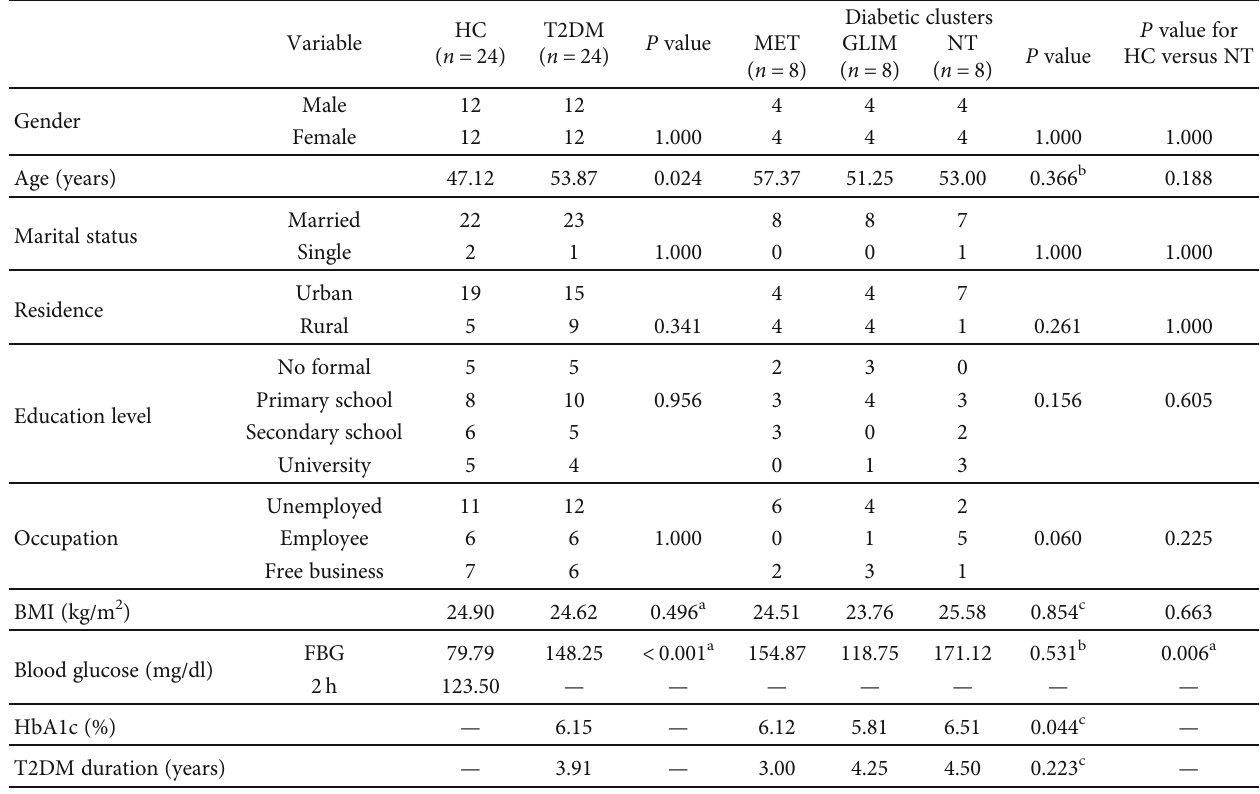
Table 1: Characteristics of the study